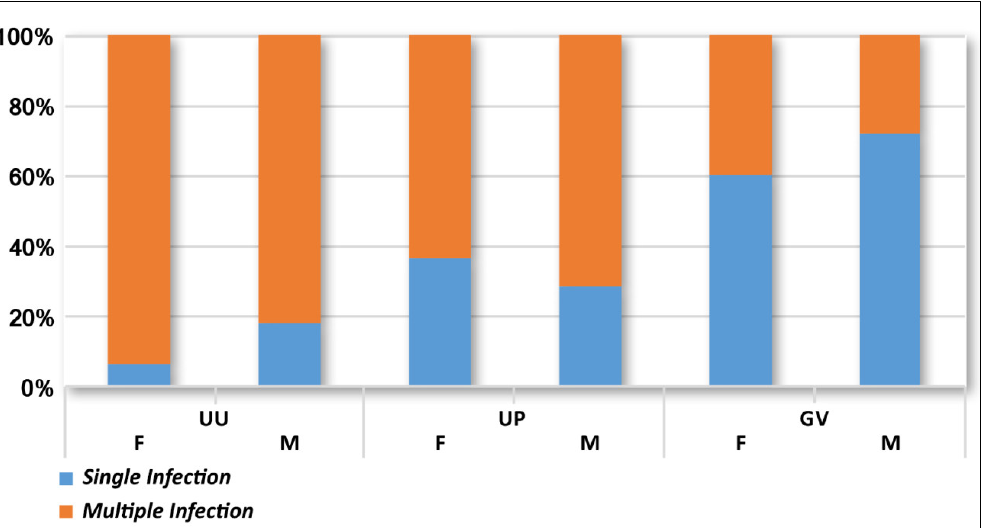
Figure 3 . Prevalence of single and multiple infections due to U. urealyticum (UU), U. parvum (UP), and G. vaginalis (GV) in samples from female (F) and male (M) patients. Our results showed that 52.34% (190/363) of women and 31.63% (112/354) of men were positive for at least one of the six genital microorganisms detected by mRT-PCR (Table 3). Overall, among vaginal/endocervical swabs collected from women, 96/363